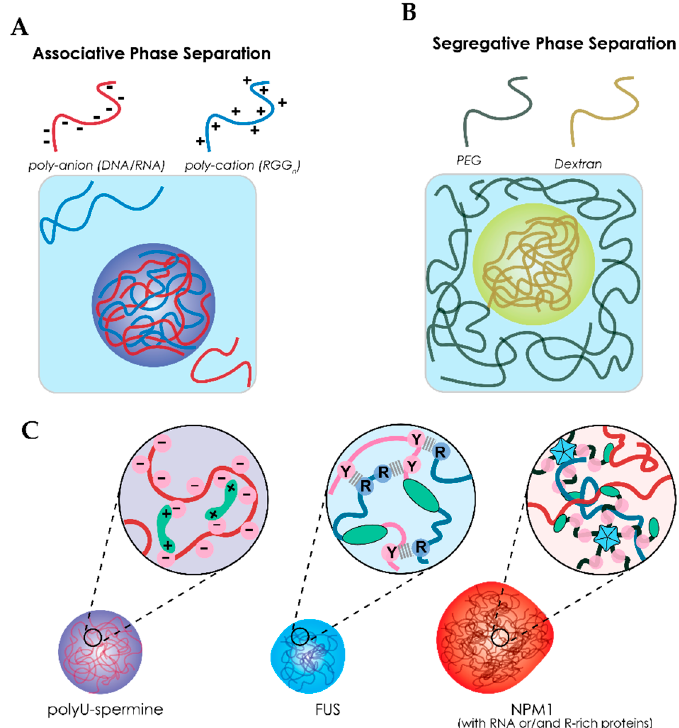
Figure 3. Liquid–liquid phase separation of proteins and polymers . Illustration of the difference between ( A ) associative phase separation which relies on attration between two macromolecules and ( B ) segregative phase separation which relies on repulsive interactions. ( C ) The three model systems from Section 4 which contains poly-U–spermine; FUS; NPM1 condensates. Poly-U–spermine condensates rely solely on charge interactions between RNA (negative) and spermine (positive). Increasing complexity, FUS has cation– π interactions between arginine (RGG motif, cation) and tyrosine ([G/S]Y[G/S] domain, π ) residues within the disordered domains. RNA could play a role but is not included in the crowded studies discussed in Section 4. Finally, NPM1 has an oligomerization domain and a nuclear-binding domain in addition to charge interactions.